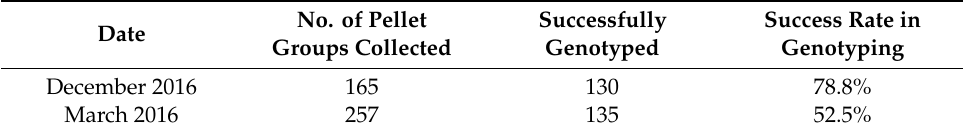
Table 2. Number of Siberian roe deer fecal samples collected and genotyping success rate in two surveys in 2016 in Liangshui National Nature Reserve, China.